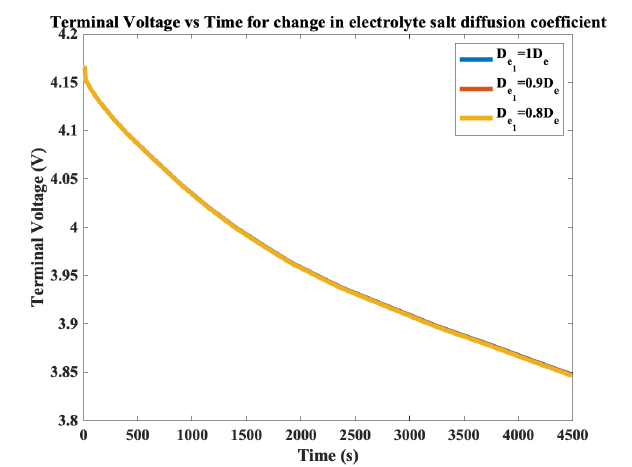
Figure 3. Terminal voltage vs. time for change in electrolyte salt diffusion coefficient from 1.0 to 0.8.